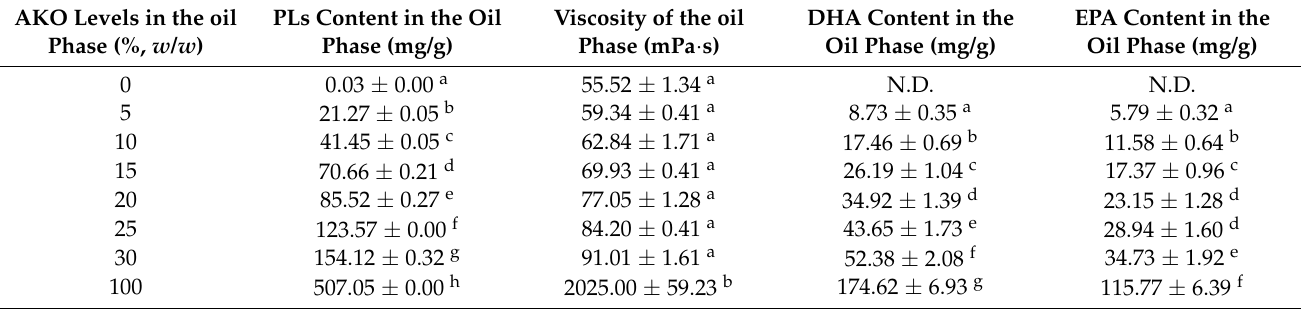
Table 2. The phospholipids (PLs) content, viscosity, and DHA and EPA content in the oil phase containing different levels of Antarctic krill oil (AKO). In each column, different letters denote significant difference ( p < 0.05). AKO Levels in the oil Phase (%, w/w